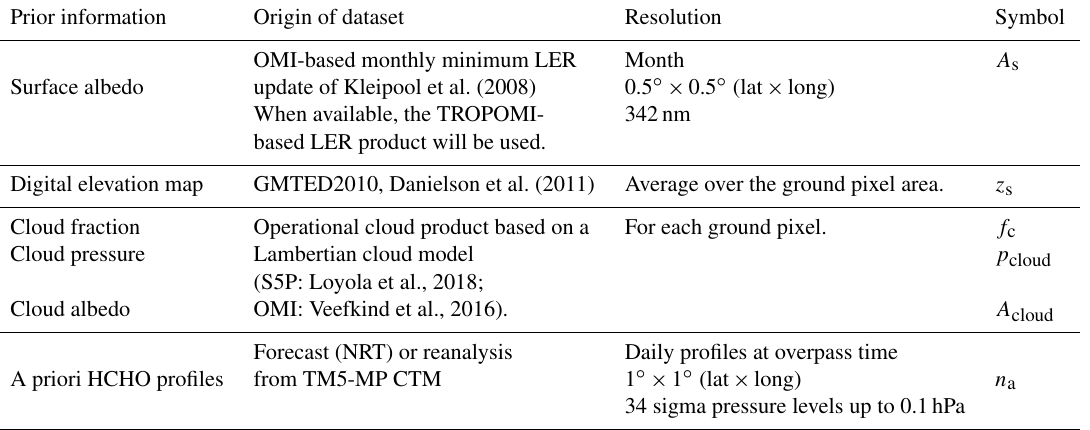
Table 5. Prior information datasets used in the air mass factor calculation in the S5P HCHO operational algorithm and in the QA4ECV OMI algorithm.